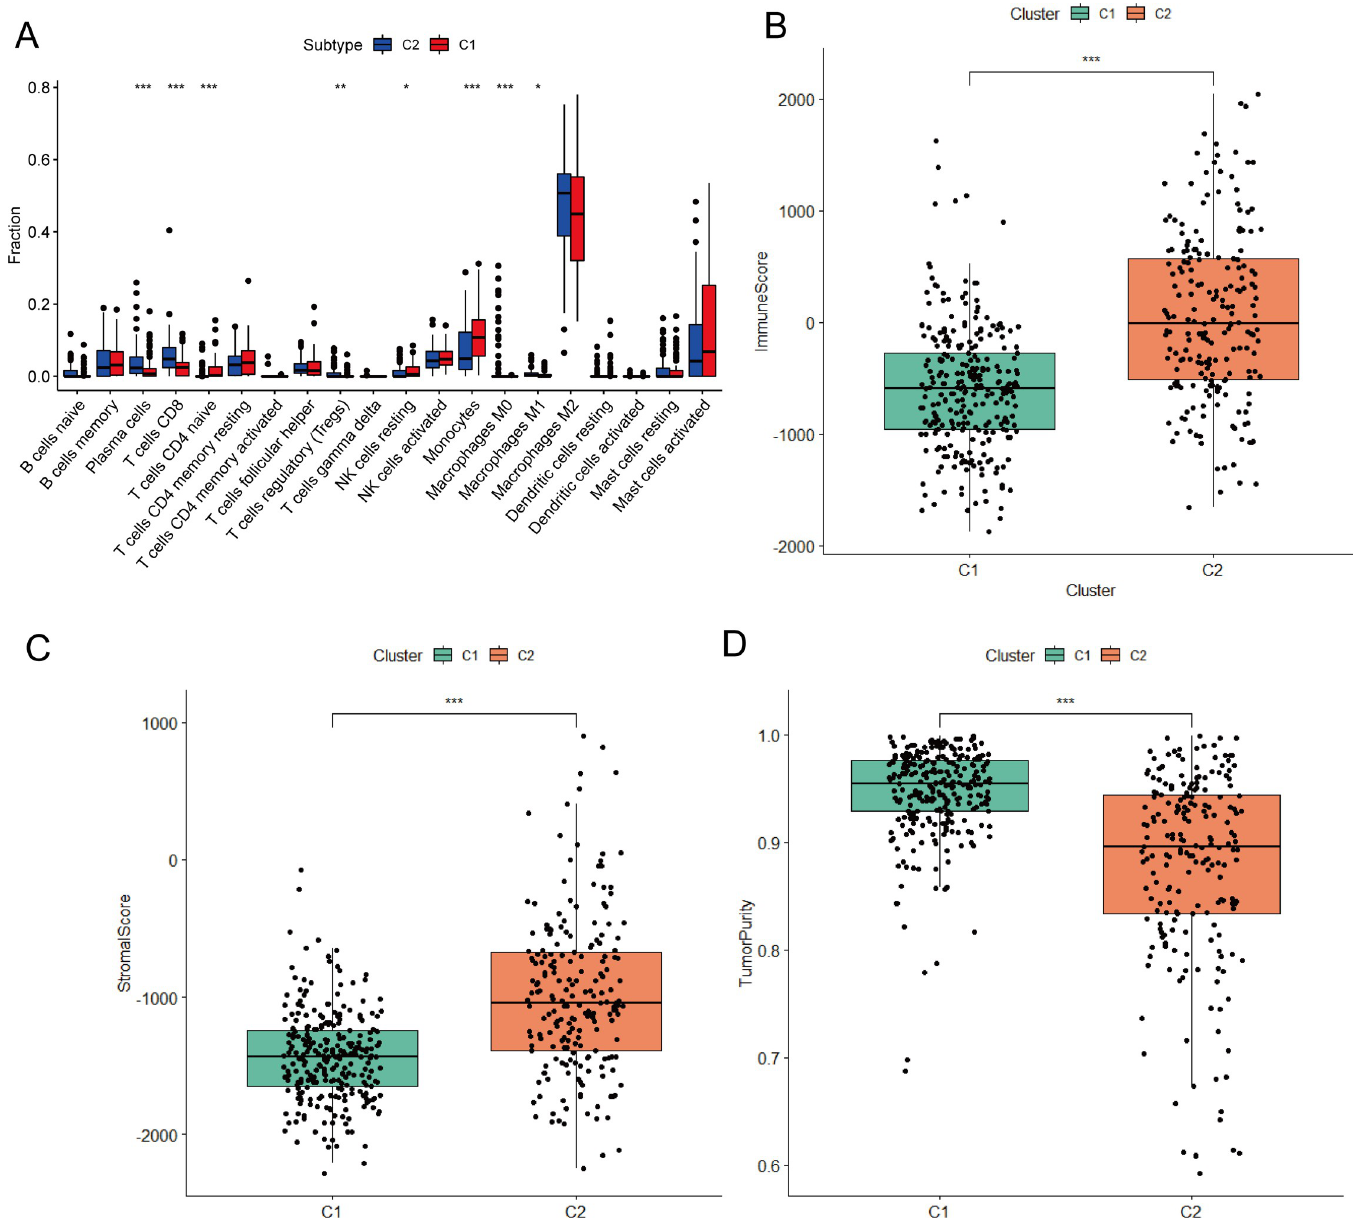
Fig 3. Correlation analysis between RNA modification subtypes and immune microenvironment. (A) Abundance of 22 infiltrating immune cell types in the two RNA modification subtypes. (B-D) Correlations between the two RNA modification subtypes and Immune Score (B), Stromal Score (C) and tumor purity (D).